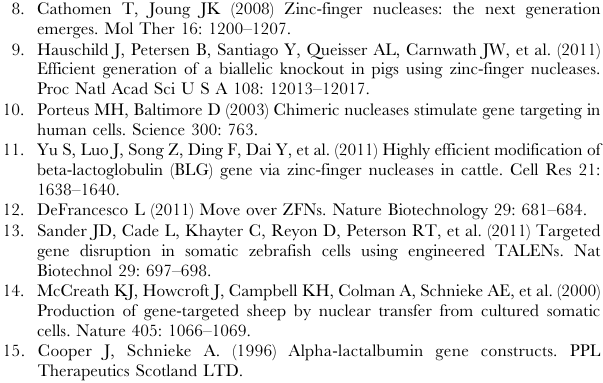
Figure S1 Plasmid map of targeting construct, pHSA- neo. (PDF) Figure S2 Primers used to test for biallelic targeting. Primer 63 is 10 bp upstream of the endogenous bovine albumin ATG, within exon 1. Primer 64 is 25 bp downstream of exon 1, within the first intron. Expected product size for primer set 63/64 is indicated in parentheses. Figure S3 Evaluation of TALEN efficiency. Sequencing results from analyzed clones (N= 48) revealing TALEN-induced indels at the target site on chromosome 6. Table S1 SCNT results for targeted and wild-type (WT) 3142 bovine fibroblast donors. One blastocyst from targeted cell line was not tested